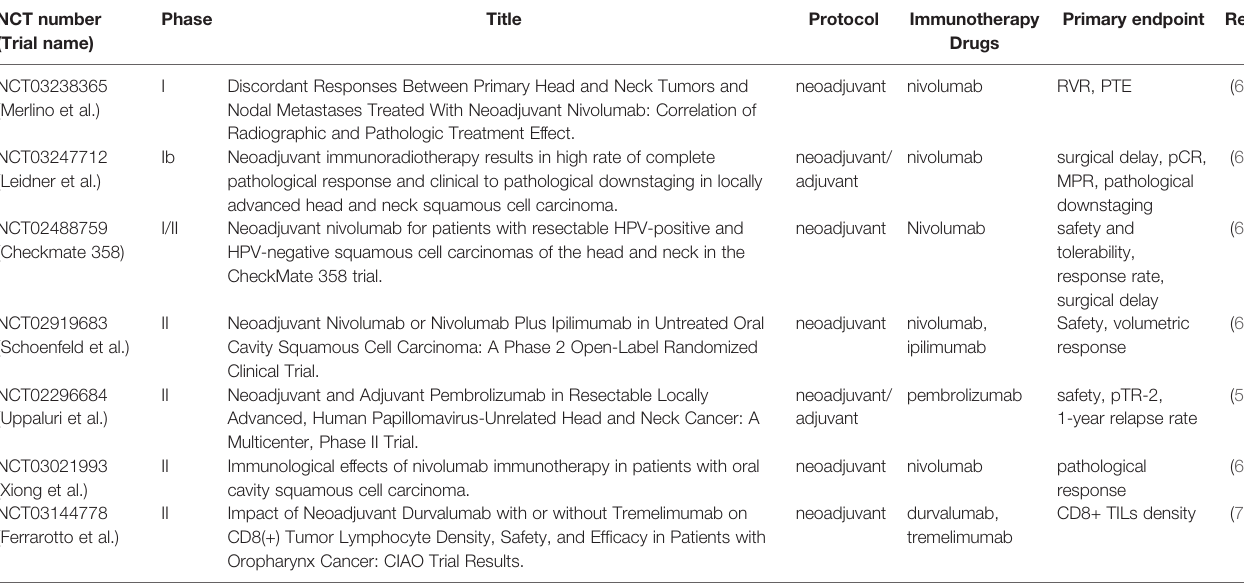
TABLE 1 | Completed neoadjuvant immunotherapy clinical